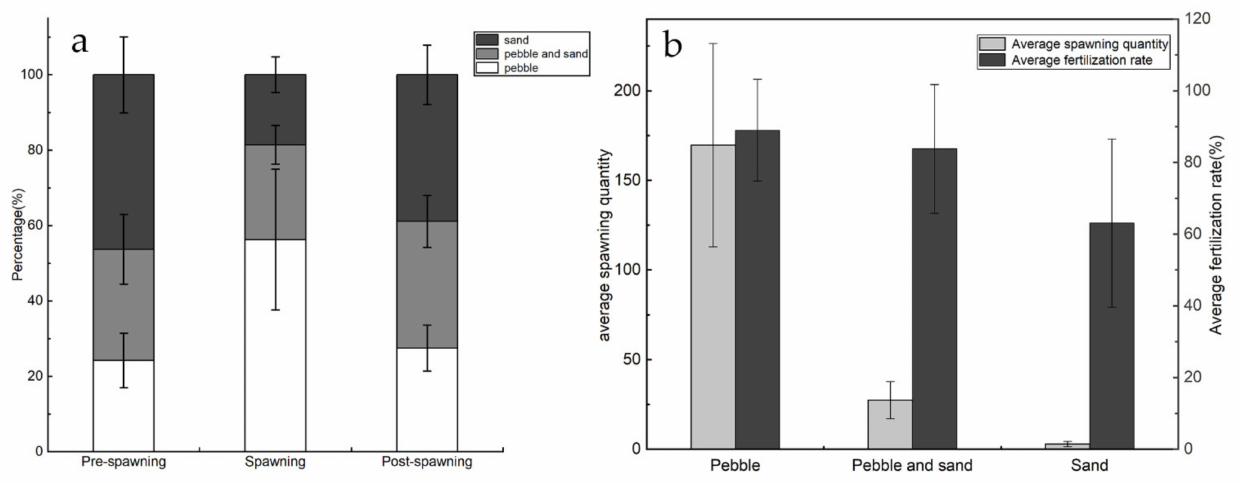
Figure 6. The proportional residence times ( a ) and average spawning quantity and fertilization rate ( b ) of G. przewalskii in the different riverbed substrate and time.